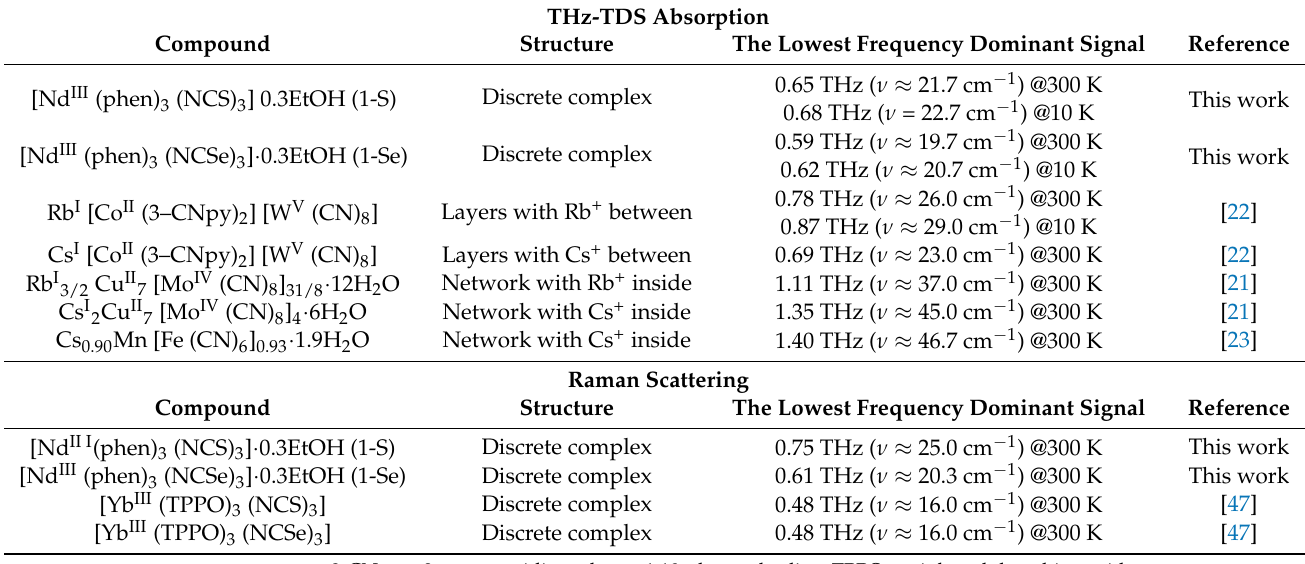
Table 1. List of compounds with the lowest frequency dominant THz-TDS and Raman signals. THz-TDS